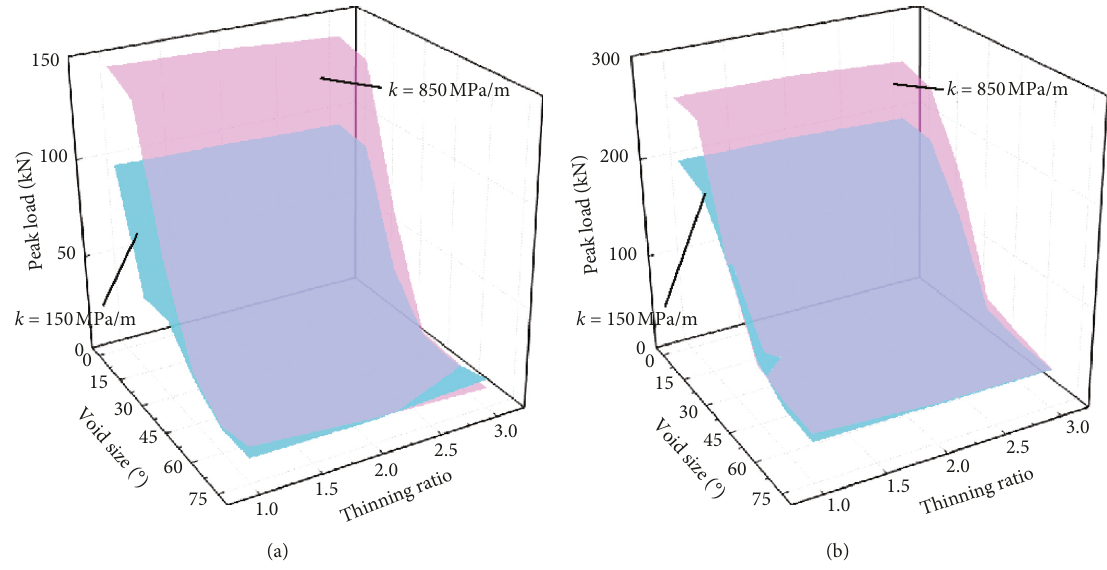
Figure 16: Three-dimensional curved surfaces of peak load and combined defects at vault crown. (a) 45 ° oblique load. (b) Horizontal